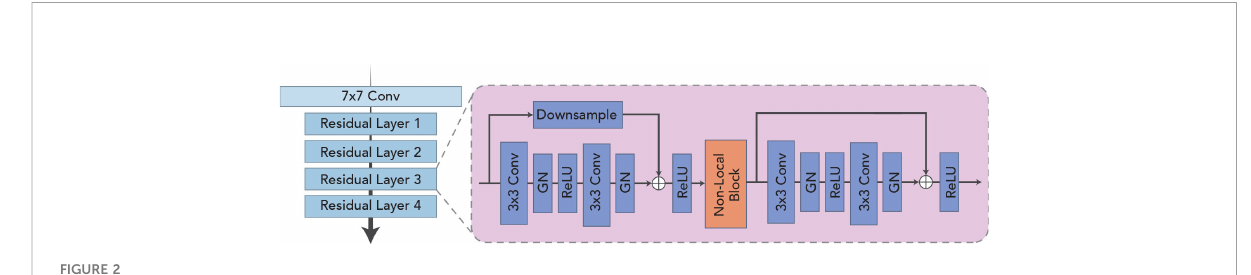
FIGURE 2 Schematic illustration of the deformed feature extraction